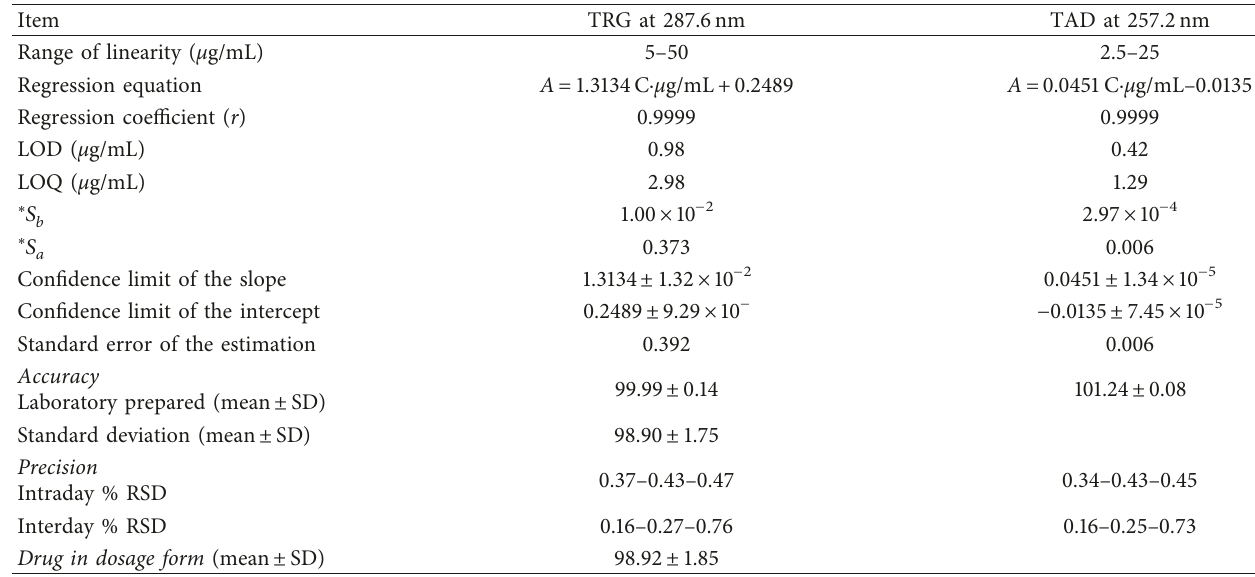
Figure 5: The mean-centered values of the ratio spectra representing 5–50 μ g/mL TRG divided by 25 μ g/mL of TAD (a) and the ratio spectra of 5–25 μ g/mL TAD divided by 50 μ g/mL of TRG (b), using methanol as a blank. Table 3: Results obtained by the proposed mean-centering spectrophotometric method for determination of TRG and TAD.